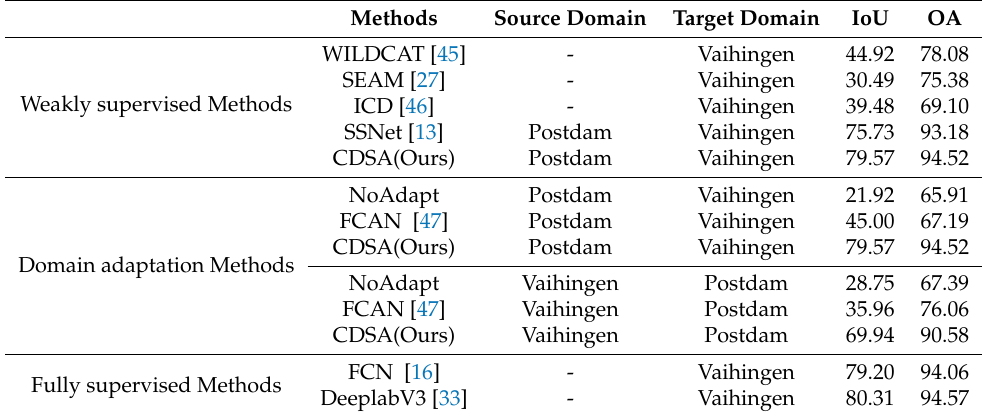
Table 3. Performence Comparisons (IoU AND OA) among Different Methods on the Vaihingen Data Set